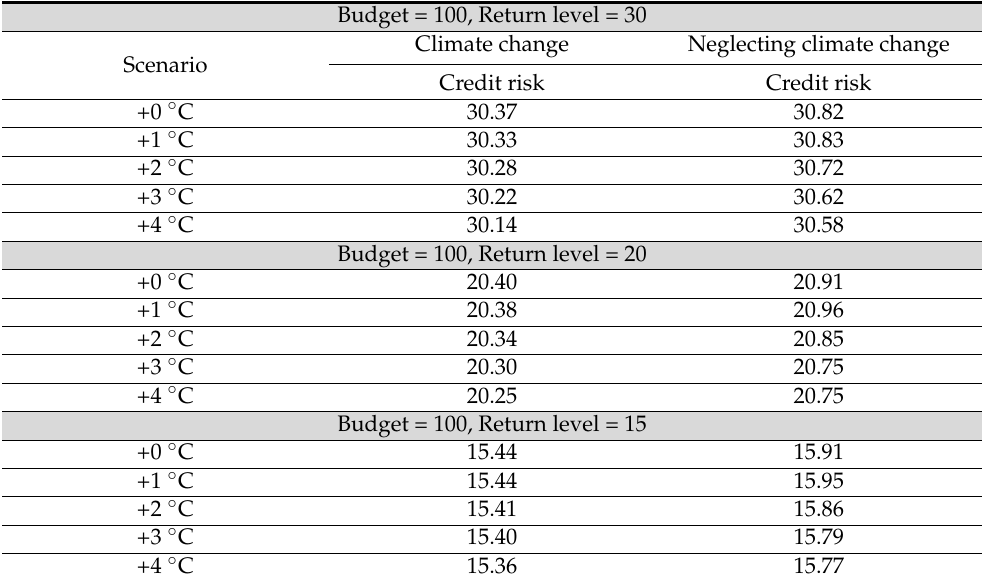
Table 3. Credit risk considering simulated loan size (in 000s CAN